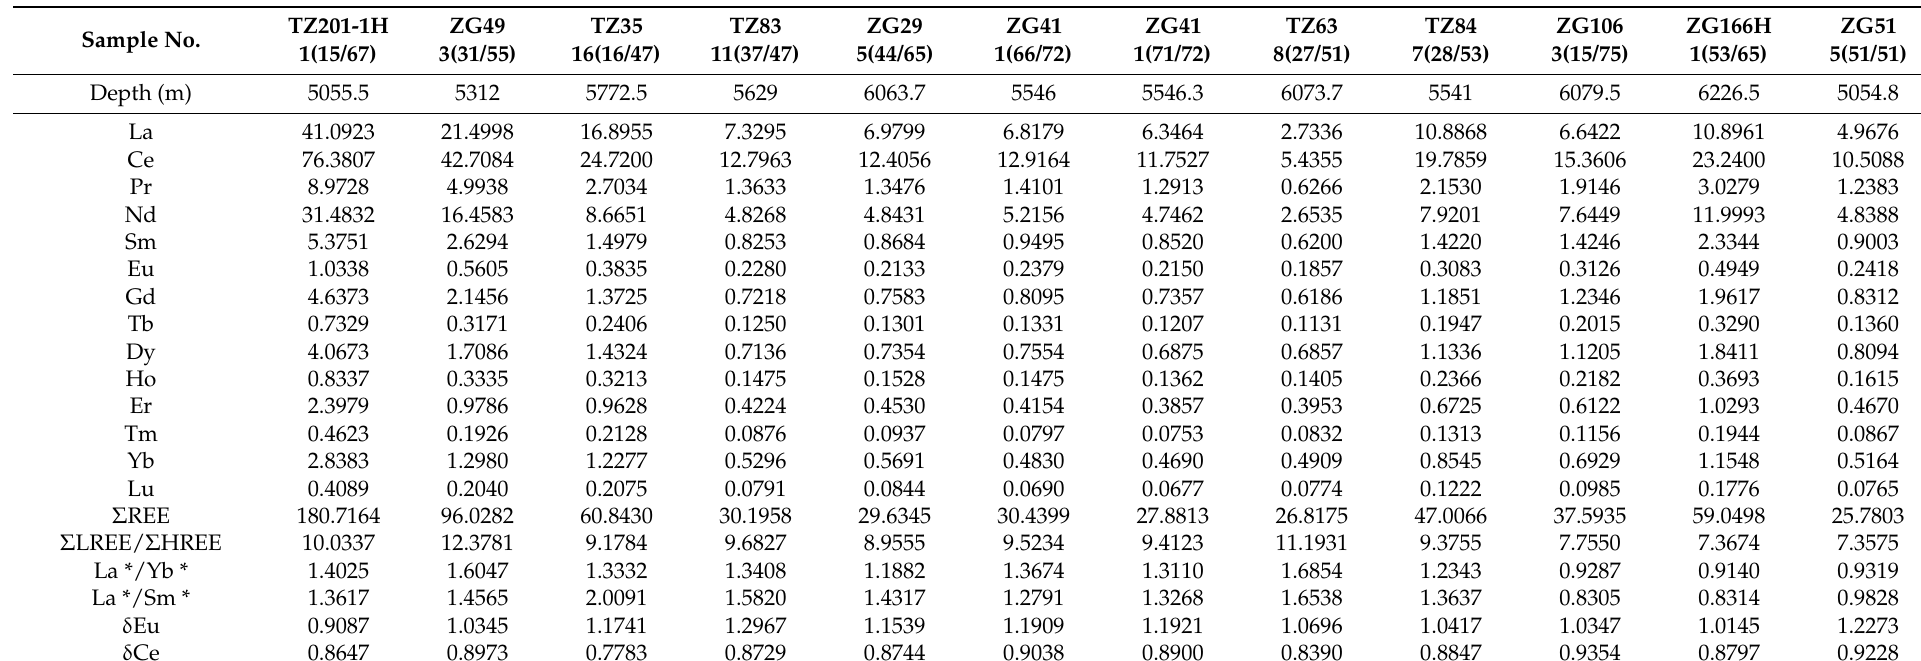
Table 4. Results of rare earth elements in marlstone at the bottom of Lianglitage Formation in the northern slope of Tazhong (ppm). Sample